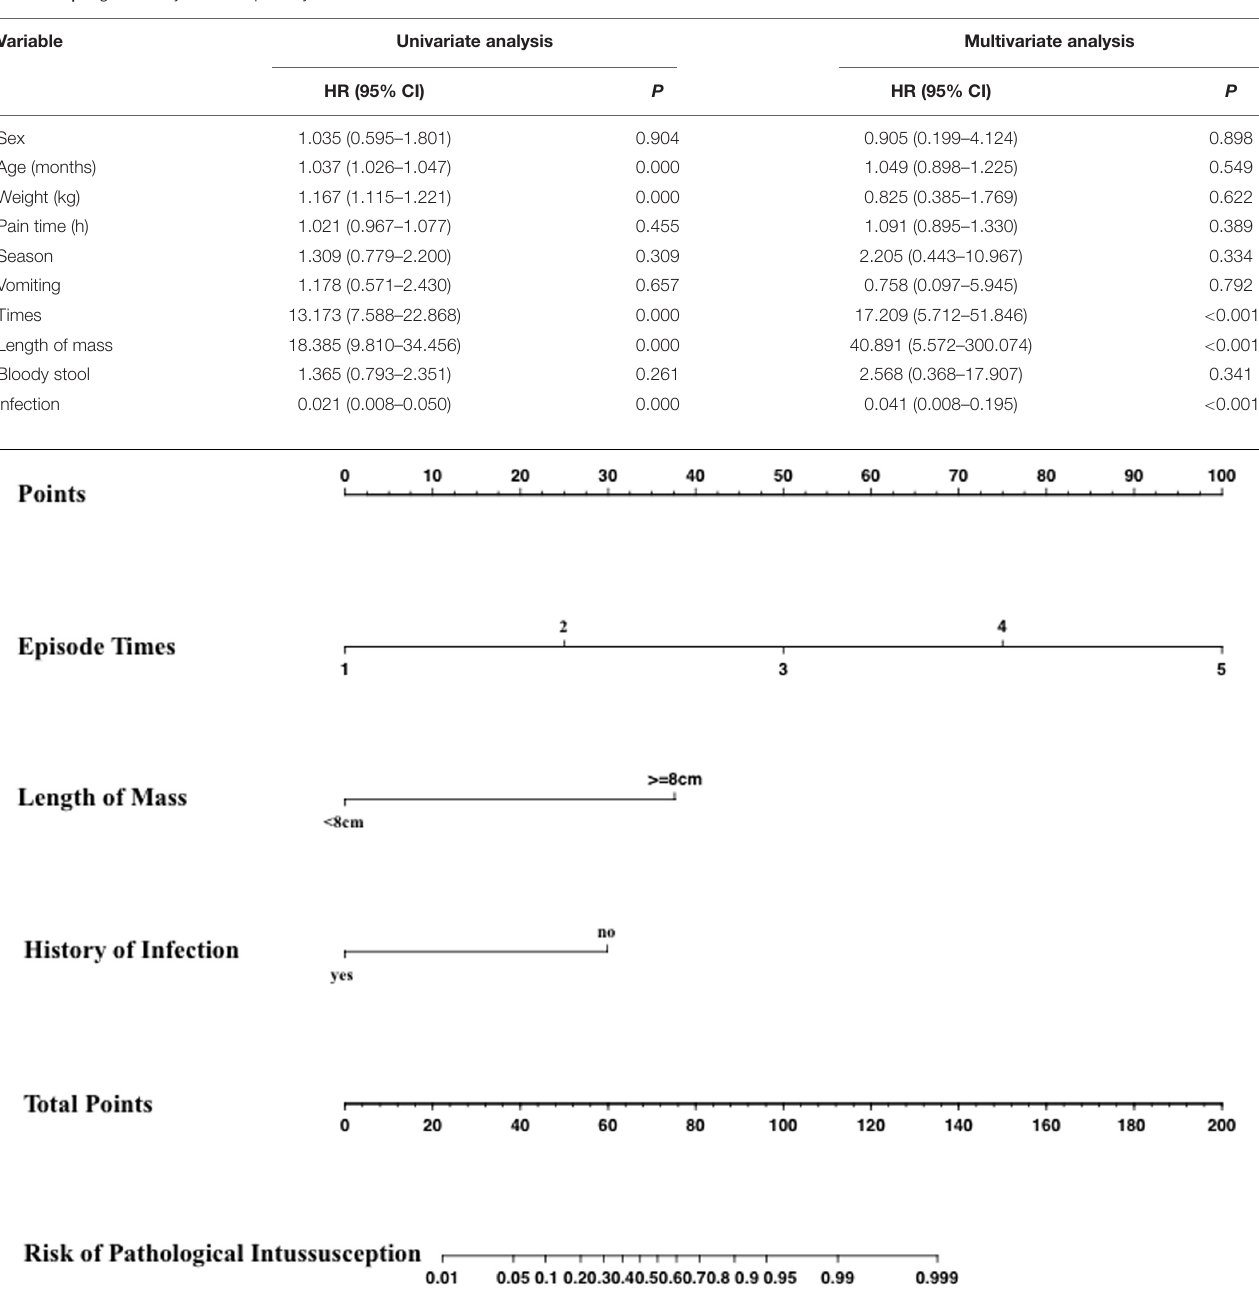
TABLE 4 | Logistic analysis of the primary cohort.